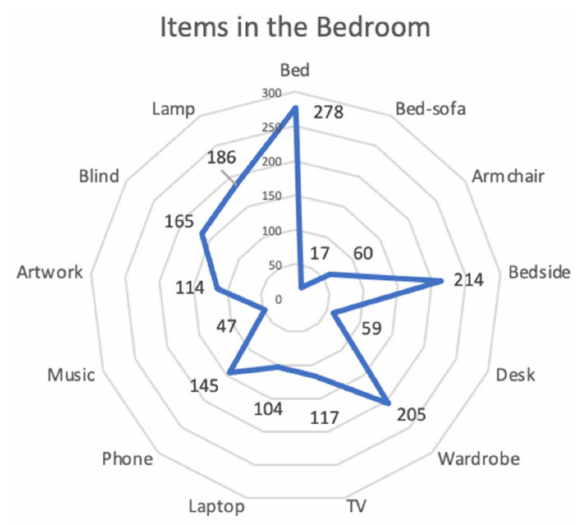
Figure 3. Representation of the items in the bedroom.